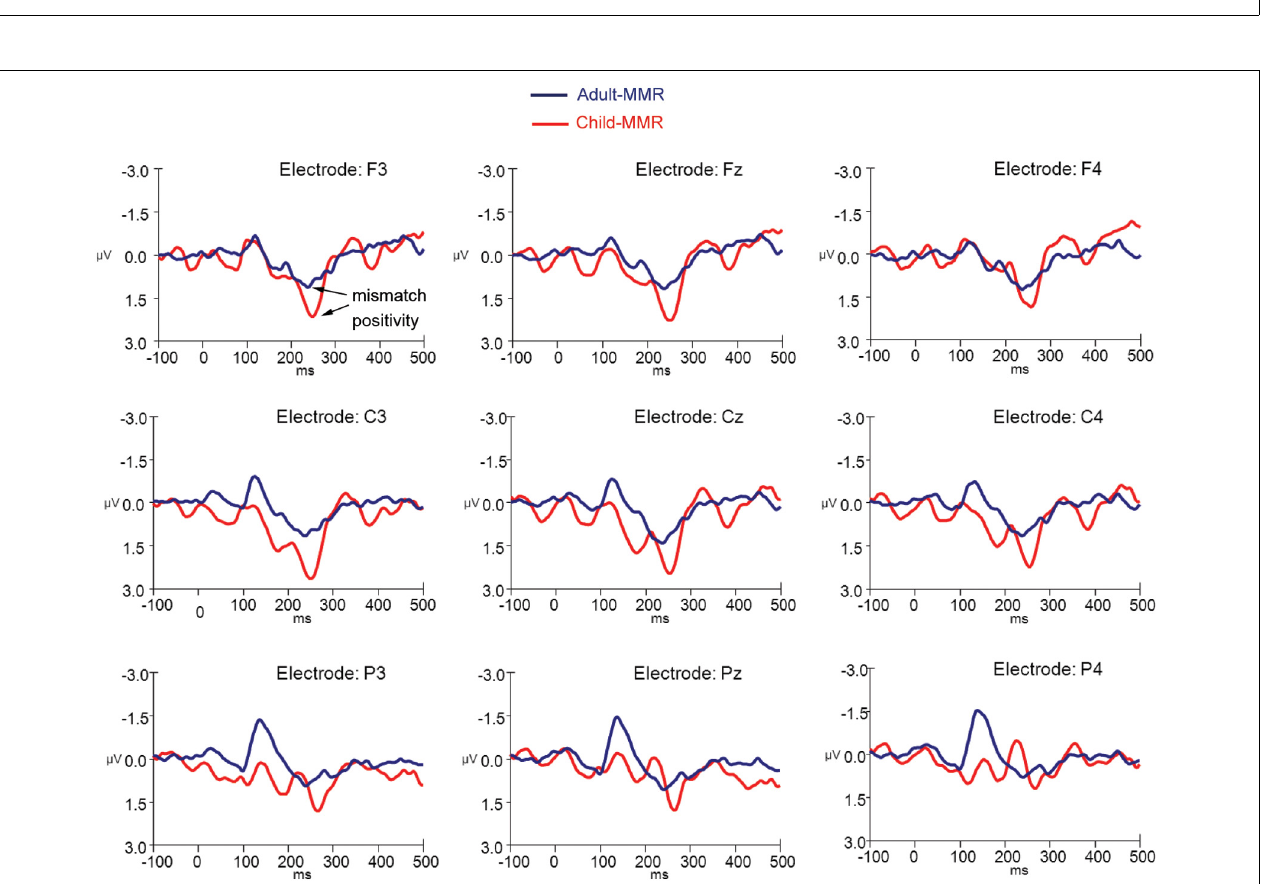
effects. This was also the case for the second negativity {main effect of Stimulus: [ F ( 1 , 20 ) = 20 . 08, p < 0 . 001]}. The repeated measures within (adult) group ANOVA for the amplitude of the positivity at around 250 ms against the aver- age baseline activity at frontal electrode positions demonstrated a main effect of Stimulus [ F ( 1 , 19 ) = 40 . 85, p ≤ 0 . 001] in the absence of any other